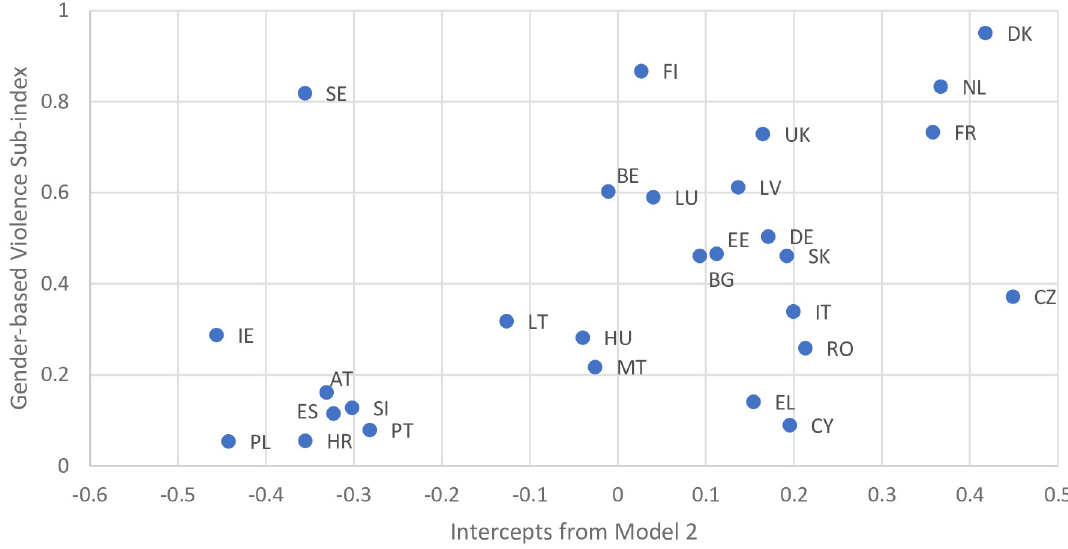
Fig 5. Relationship between adjusted levels of violence against women and the gender-based Violence sub-index (Violence Regimes